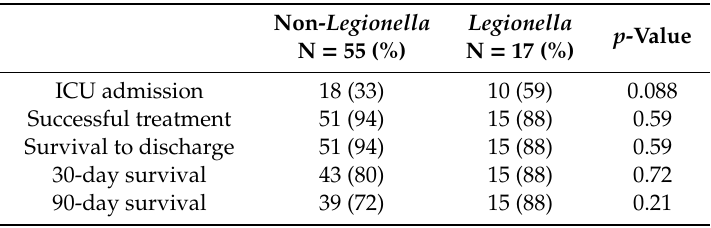
Table 3. Patient outcomes by group. ICU: Intensive Care Unit. Successful treatment refers to resolution of pneumonia clinical symptoms. p -Values obtained by Fisher exact